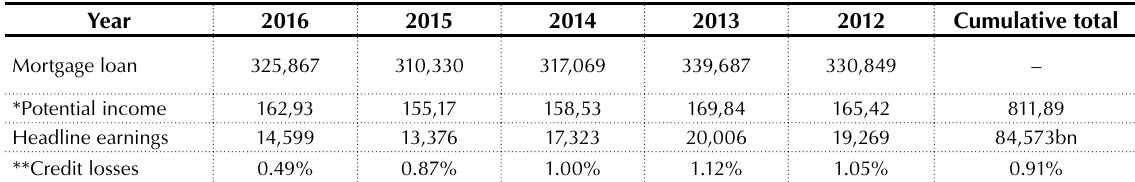
Table 3. Bank C potential BASF income as a function of mortgage loans and credit